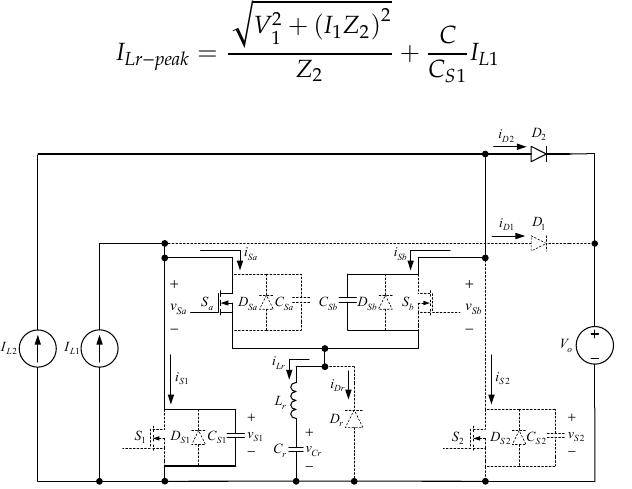
Figure 5. Current path in mode 2.